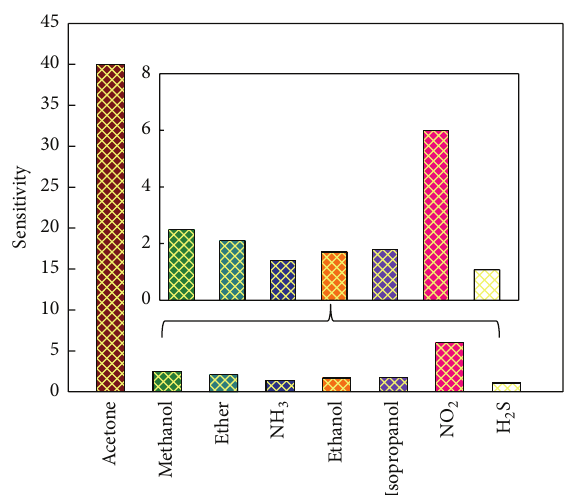
Figure 5: Responses of the flower-like Cu-WO 3 gas sensor to different gases at 110 ∘ C.